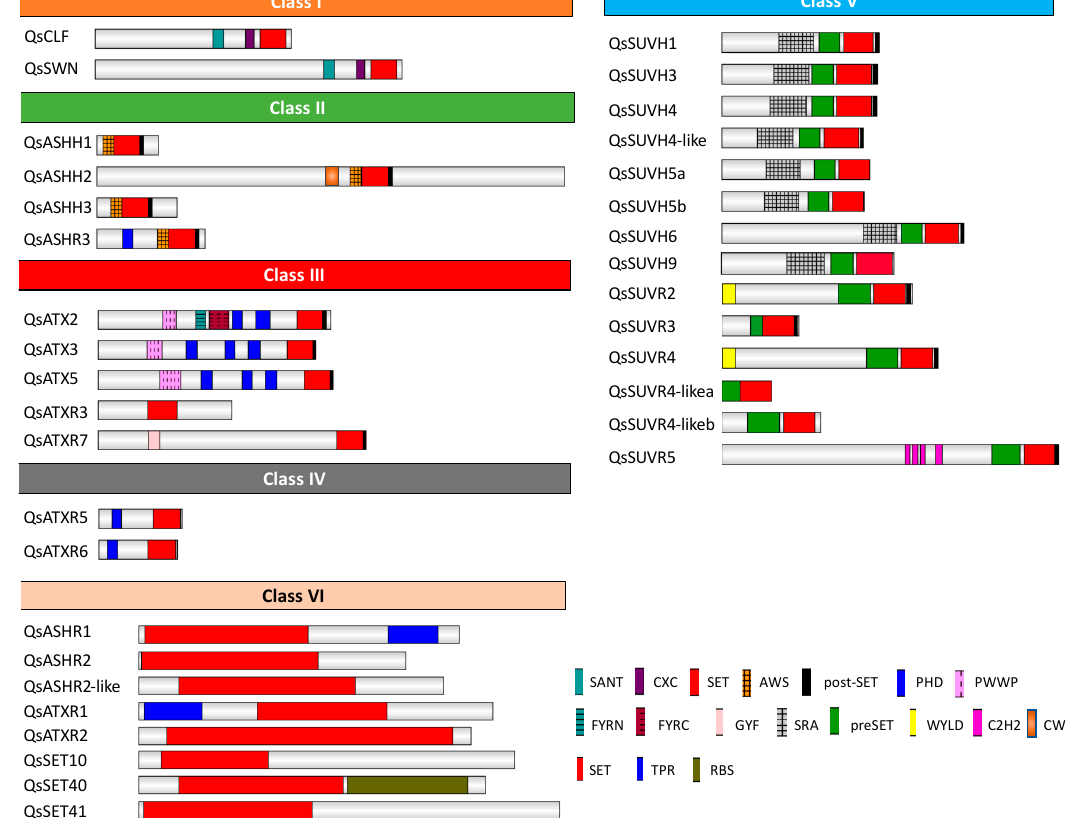
Figure 5. Domain organization of the Quercus suber L. histone methyltransferases proteins. Schematic diagrams show the domain organization of the enzymes. The protein names and the family they belong to are indicated on the left side and above each corresponding schematic diagram, respectively. The different conserved protein domains are shown in different colors as indicated in the legend on the right side. SANT (SM00717), CXC (PF03638), and SET (PF00856) are conserved domains